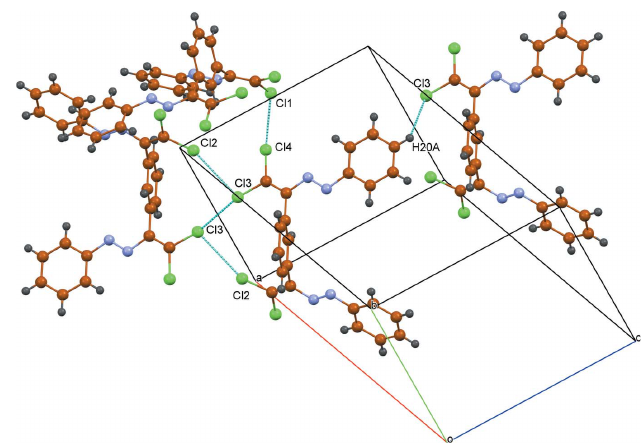
Figure 3 A fragment of the molecular packing showing the Cl (cid:2)(cid:2)(cid:2) Cl and Cl—H interactions.